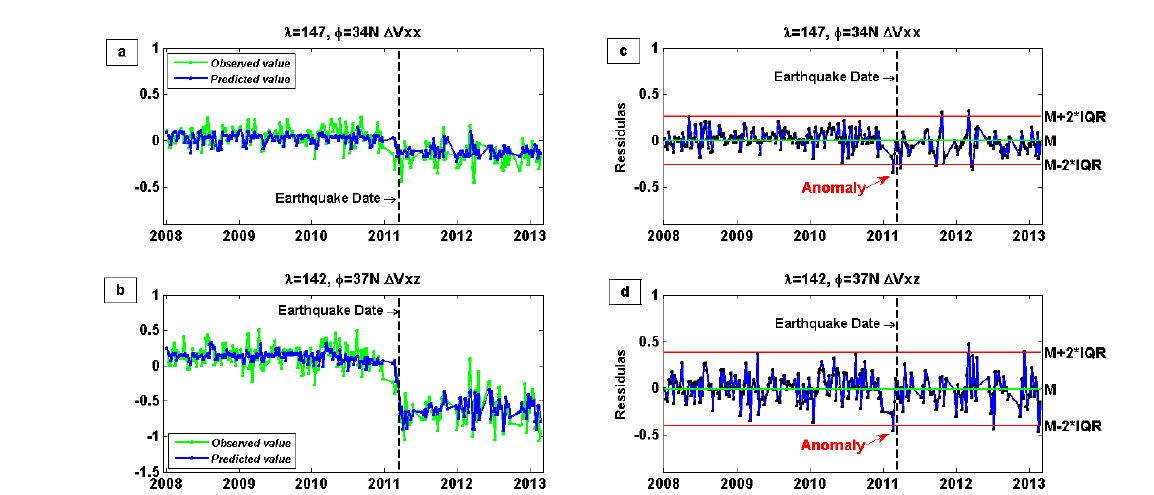
Figure 9. Same as Figure 6 for Tohoku-Oki earthquake.